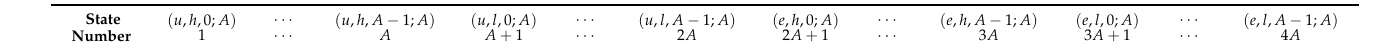
Table 4. Numbering convention for